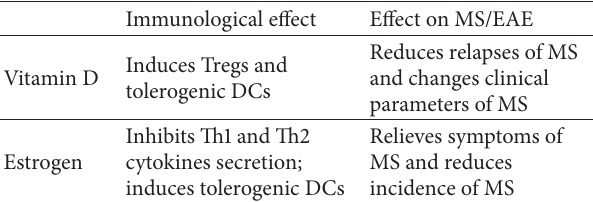
Table 3: Factors associated with MS and